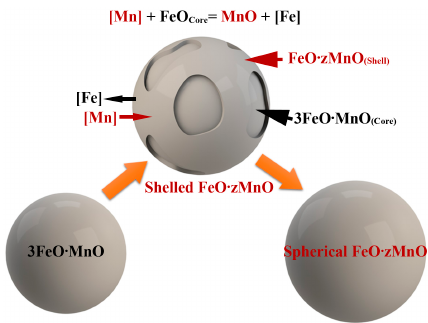
Figure 4. Schematic illustration of the evolution of MnO-FeO inclusions. Spherical 3FeO · MnO (left-hand) forms a molten-glass-like product before the melt reaches the solidification temperature. The center sphere is a shell-core inclusion formed by dissolved Mn diffusing towards 3FeO · MnO to nucleate FeO · zMnO shell on 3FeO · MnO. 3FeO · MnO forms the solid core after solidification, leaving a distinct shell-core structure.